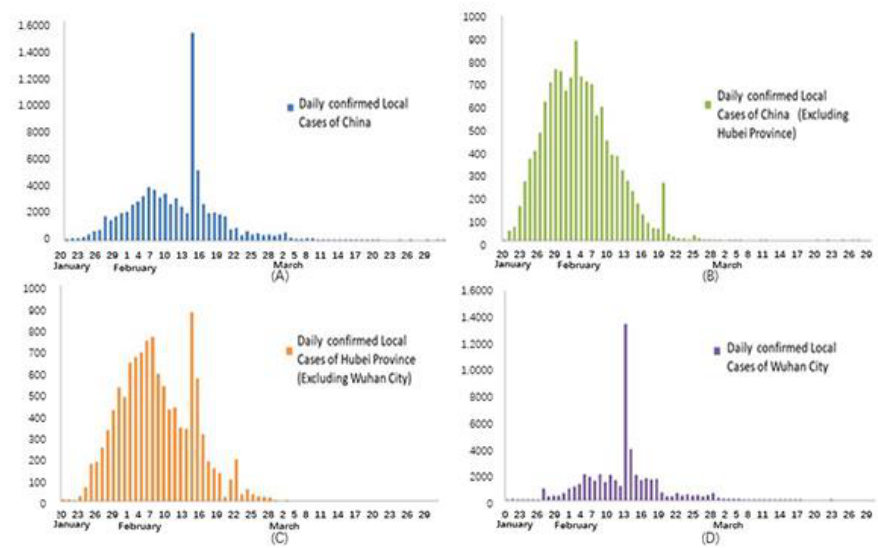
Figure 2. Daily confirmed local cases in China and the most affected areas, shown in ( A – D ). The figures show that, in the most affected areas in China, including Wuhan and Hubei Province, the first wave of the COVID-19 pandemic basically ended in the middle and late March and entered the sporadic stage. The pandemic in the less affected areas of China ended earlier.